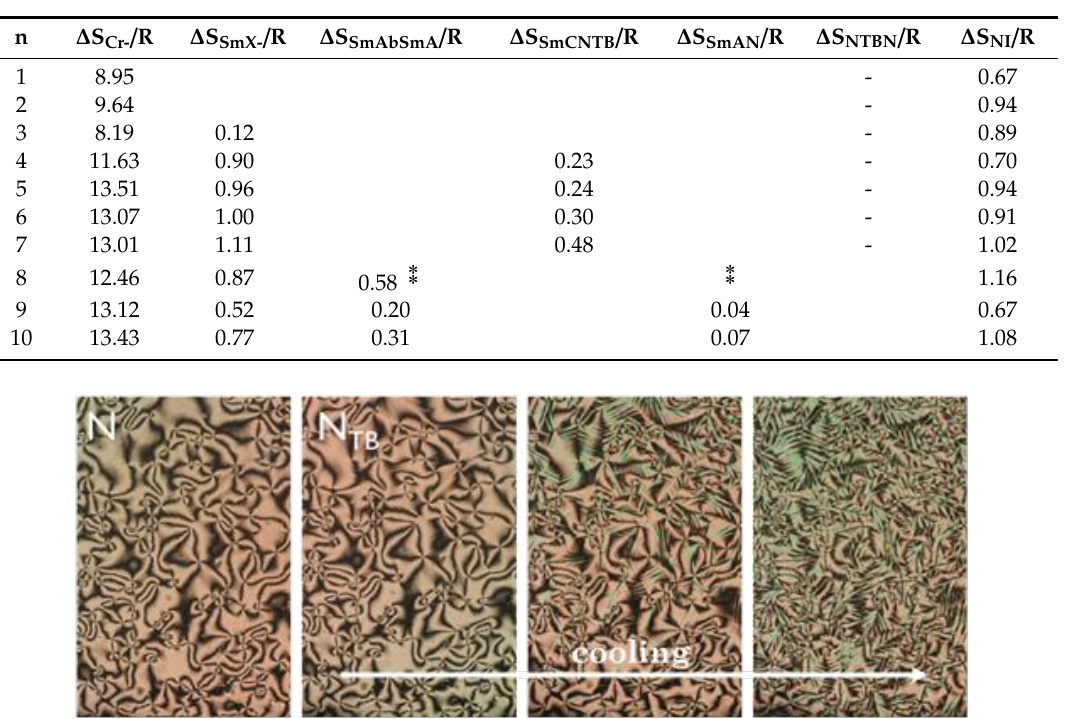
Figure 3. POM images of CB6OBA:1OS in the N phase (left) and showing the development of the N TB texture on cooling.